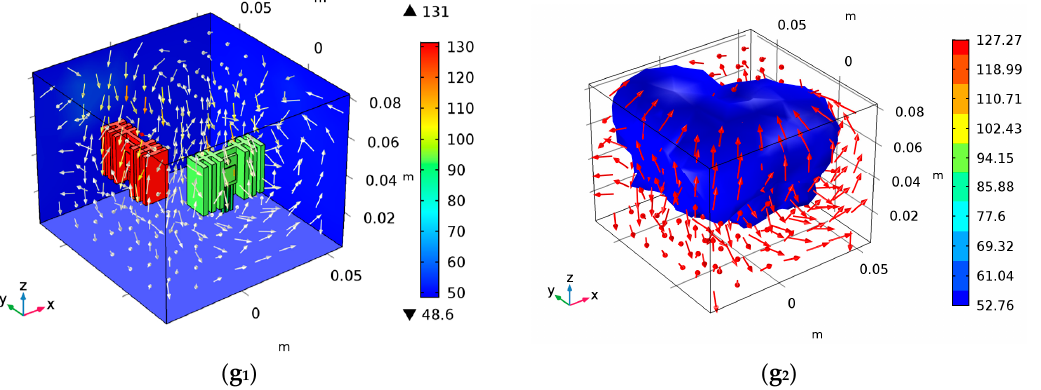
Figure 13. Simulation analysis of convection thermal coupling. ( a 1 , a 2 ) are temperature distribution and iso-surface distribution when T a = − 10 °C; ( b 1 , b 2 ) are temperature distribution and iso-surface distribution when T a = 0 °C; ( c 1 , c 2 ) are temperature distribution and iso-surface distribution when T a = 10 °C; ( d 1 , d 2 ) are temperature distribution and iso-surface distribution at T a = 20 °C; ( e 1 , e 2 ) are temperature distribution and iso-surface distribution at T a = 30 °C; ( f 1 , f 2 ) are temperature distribution and iso-surface distribution at T a = 40 °C; ( g 1 , g 2 ) are temperature distribution and iso-surface distribution at T a = 50 °C.